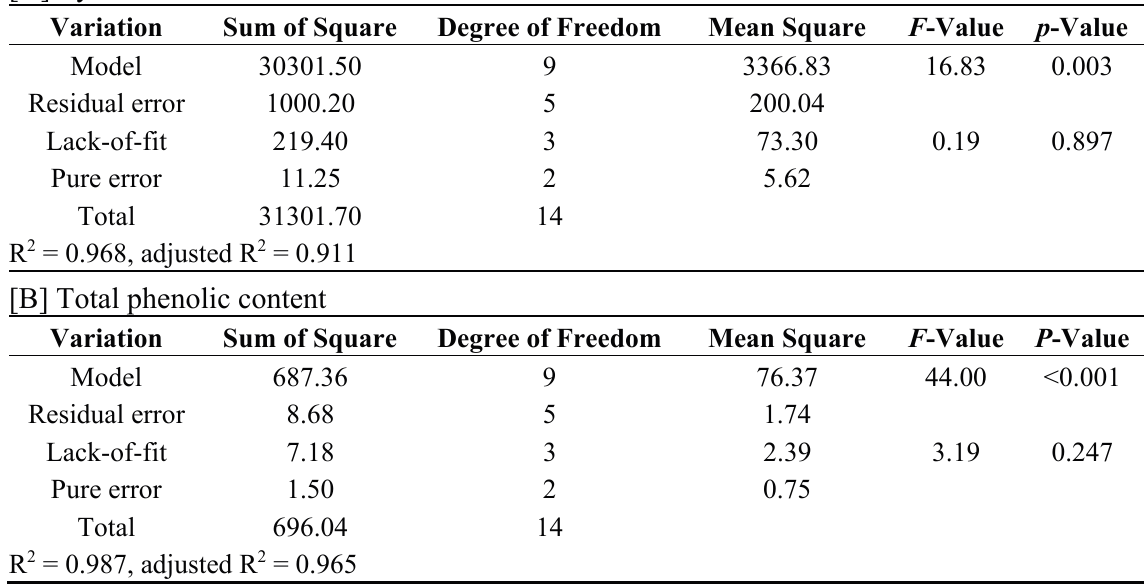
Table 2. ANOVA analysis for second order polynomial models for tyrosinase inhibition and total phenolic content.